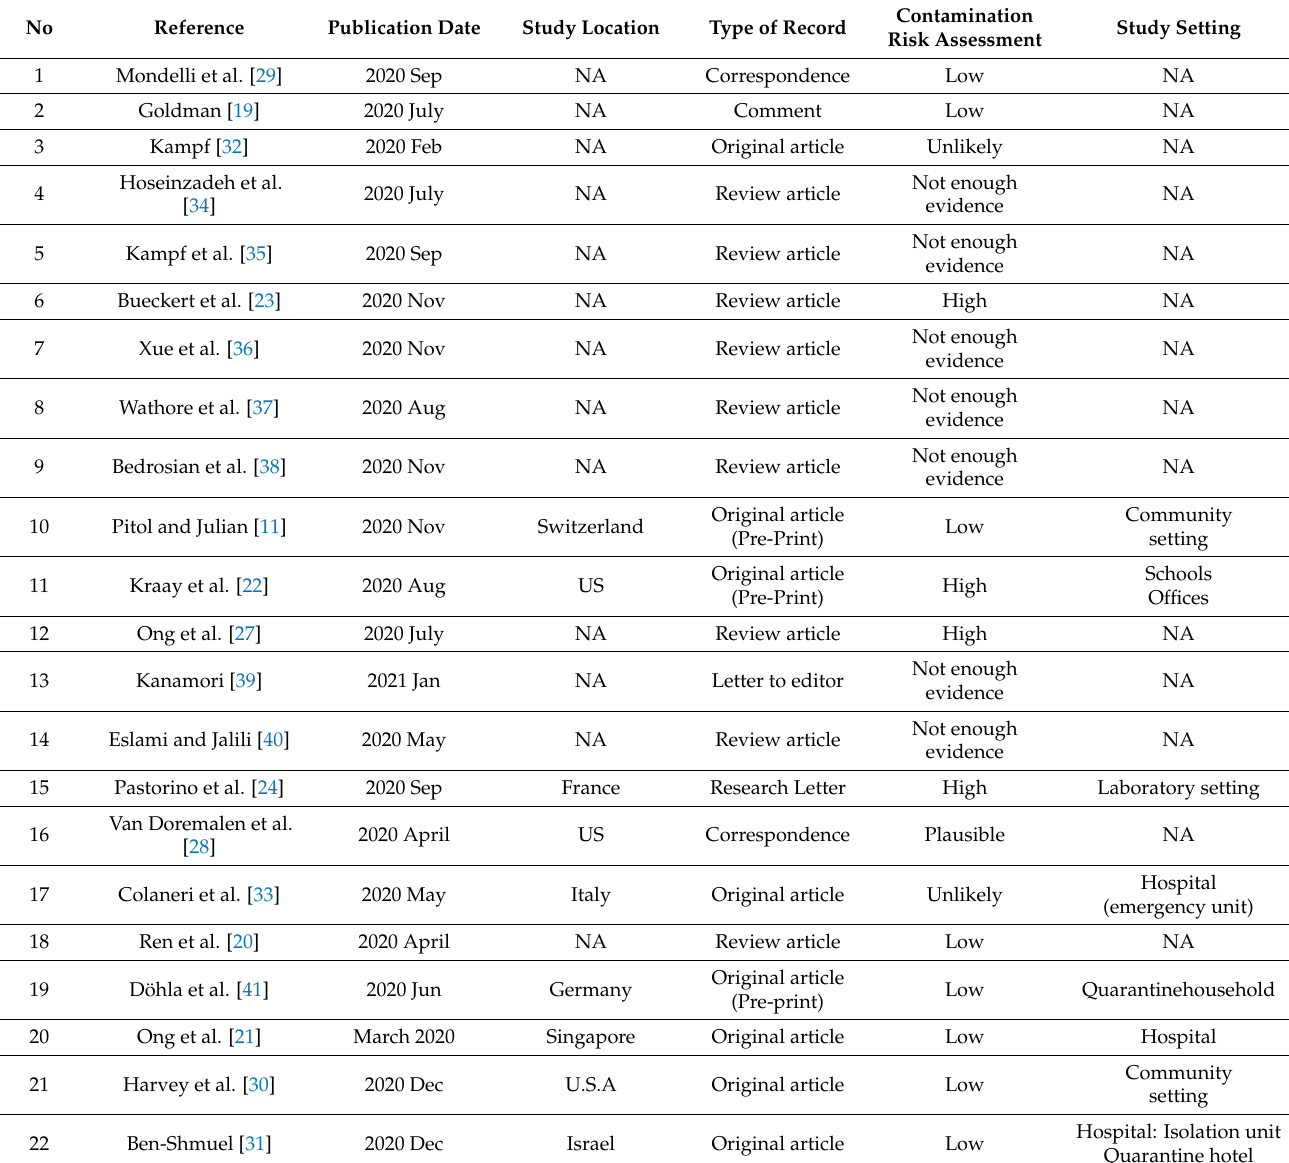
Table A1. Detailed information of review